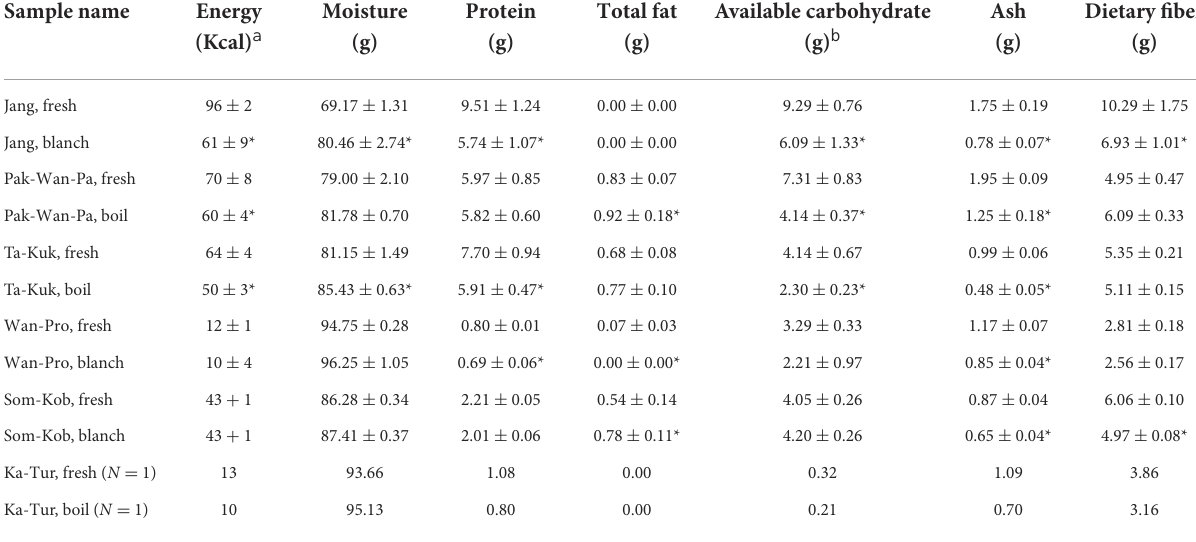
TABLE 2 Nutrients in the indigenous plants (per 100g fresh weight, N =